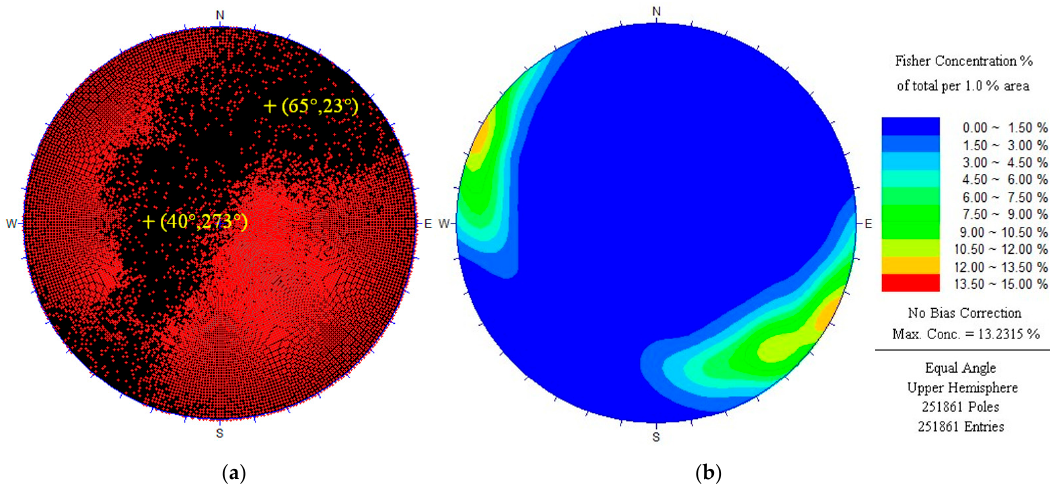
Figure 15. ( a ) The pole plot of local attitudes for 251,861 points in the experimental TLS point cloud; ( b ) The contour plot of local attitudes for 251,861 points in the experimental TLS point cloud. Figure 15b shows the contour plot generated from local attitudes for 251,861 points. The contour plot describes poles density distribution characteristics and laws by use of isopleth based on the pole plot. The color gradations in Figure 15b represent fissure developmental state.